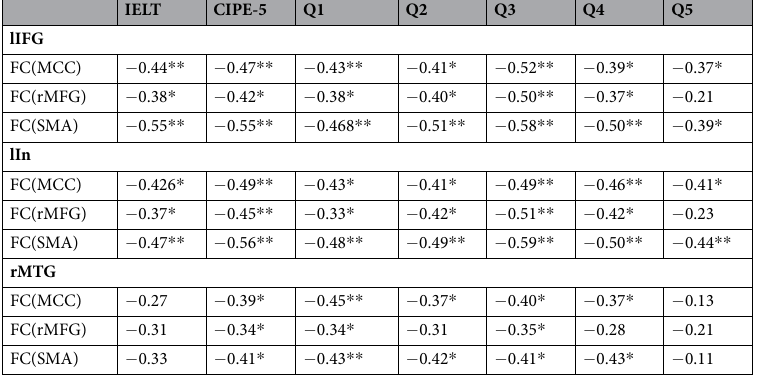
Table 3. Pearson’s correlation of functional connectivity between three brain areas and clinical scale scores. MCC: middle cingulate cortex; rMFG: right middle frontal gyrus; SMA: supplementary motor area; rMTG: right middle temporal gyrus; lIFG: left inferior frontal gyrus; lIn: left insula; * p < 0.05; ** p <